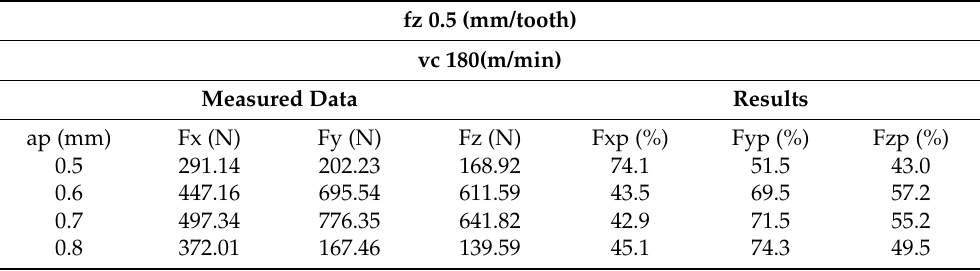
Table 13. Results for fz = 0.5 mm/tooth and vc = 180